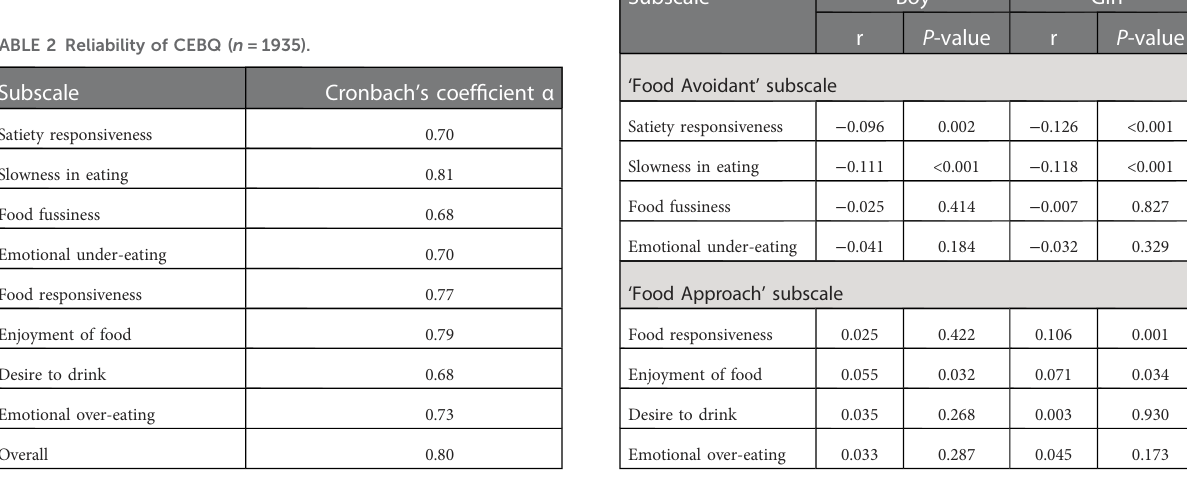
TABLE 3 Pearson ’ s correlations between the CEBQ subscales and children ’ s BMIZ ( N =1935).